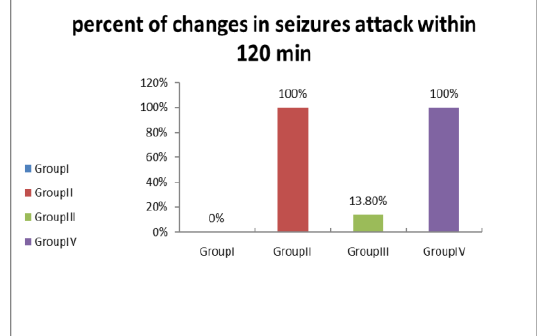
Figure 5. The percent of changes in the number of clonic seizures attack induced by yohimbine HCl (Group I) and other treated groups (Diazepam+ yohimbine HCl (Group II), omega 3 fatty acids +yohimbine HCl (Group III) and omega 3 fatty acids +Diazepam +yohimbine HCl (Group IV) at